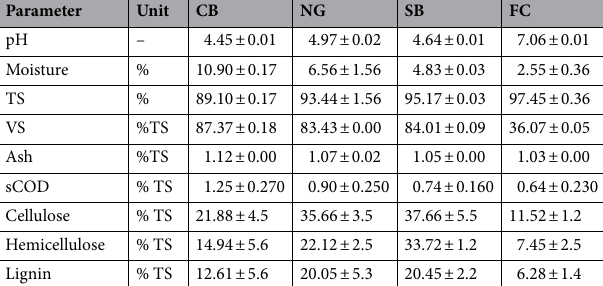
Table 1. Characteristics of the substrates used in this